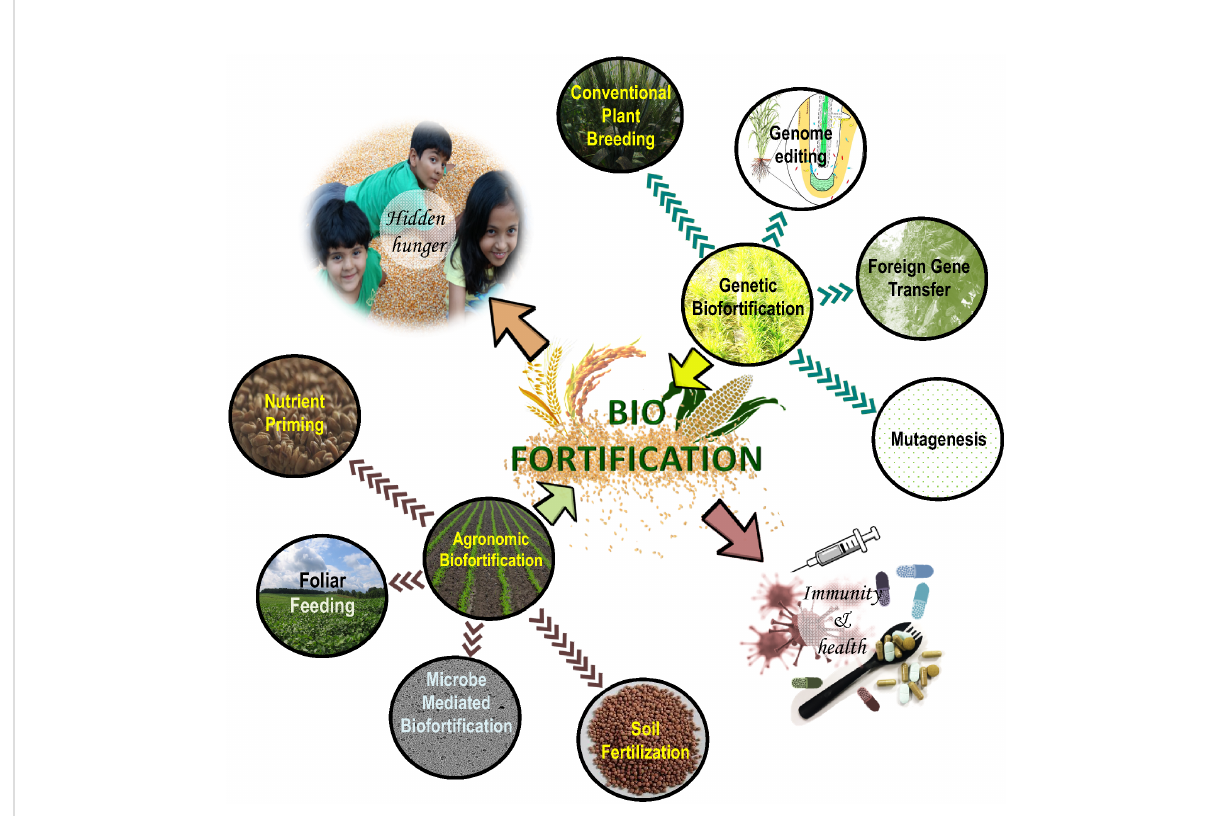
FIGURE 2 Conventional and advanced bioforti fi cation techniques used in crop production and improvement